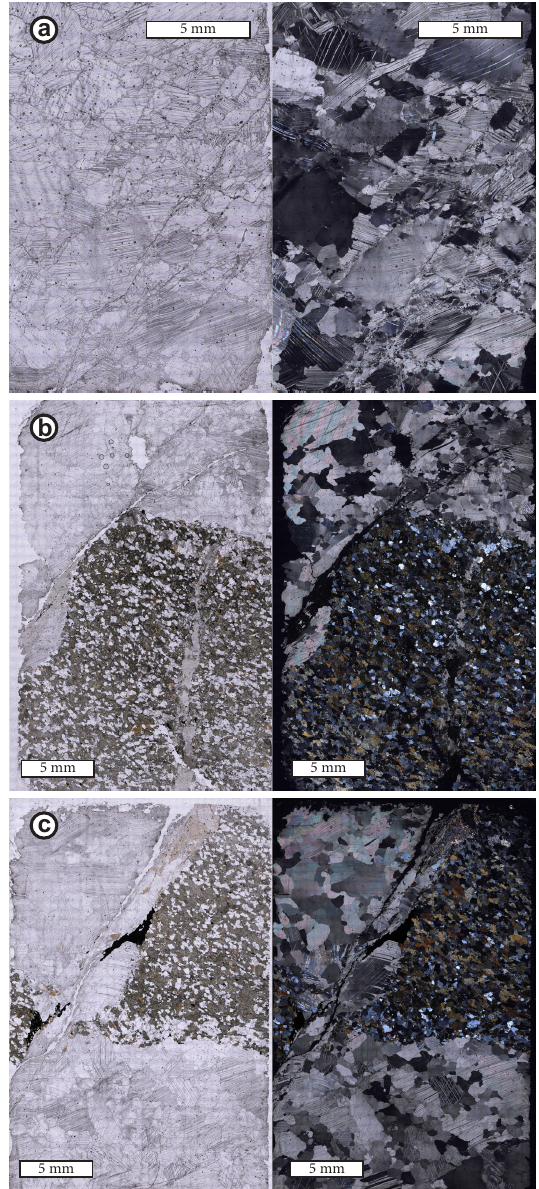
Figure 13. Neighbouring thin sections showing the localized de- formation of a domino boudin (see Fig. 12 for location). Each sec- tion is shown in plane-polarized light (left) and cross-polarized light (right). (a) In the marble ∼ 2cm away from the amphibolite numer- ous parallel shear zones can be found. Grains along the shear zones show intense twinning and undulose extinction. (b) At the inter- face of the amphibolite the shear zones have merged into a single slip zone; the fine-grained calcite fill easily breaks out during thin- section preparation. (c) The shear zone is partly filled with biotite and pyrite along the boudin face. The calcite in the zone between the separated blocks is intensely twinned and shows undulose ex- tinction. Amphibole grains are heavily